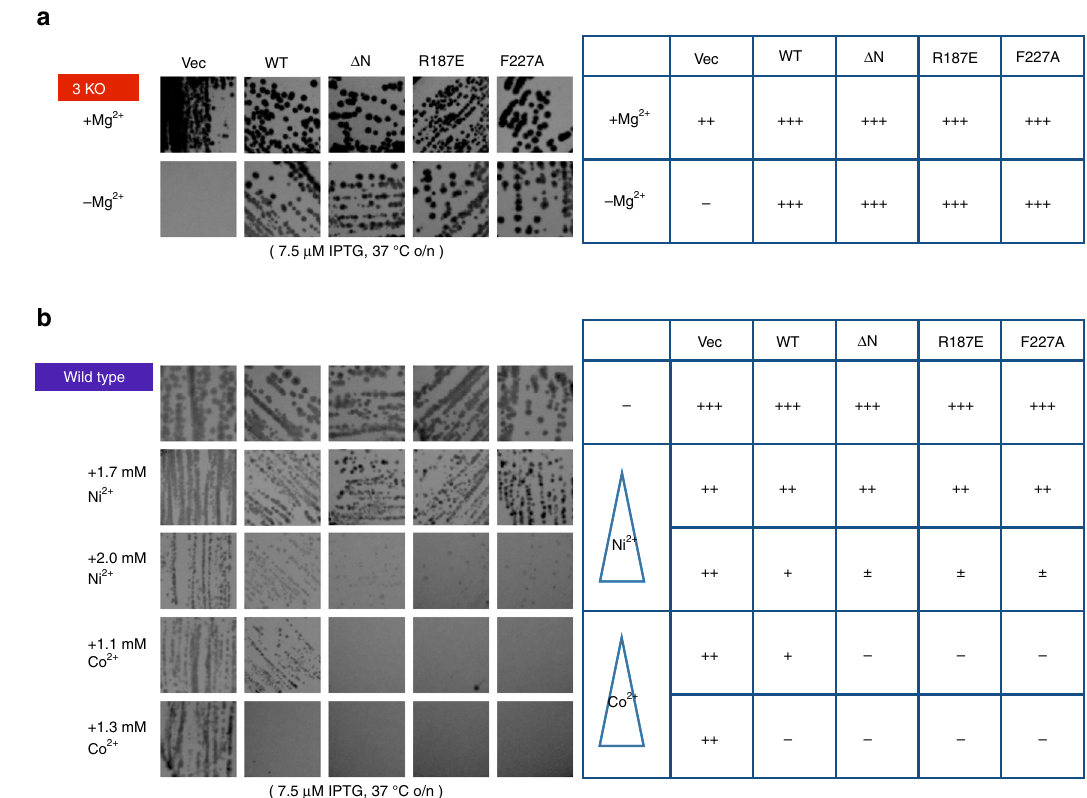
Fig. 6 E. coli growth assay of ATP-binding site mutants. a Mg 2+ -auxotrophic growth complementation assay. The Mg 2+ -auxotrophic E. coli strain, transformed with each plasmid, was streaked on LB or LB with 100 mM MgSO 4 . b Co 2+ and Ni 2+ sensitivity assays. The wild type E. coli strain (W3110 DE3), transformed with each plasmid, was streaked on LB or LB with 1.7 mM Ni 2+ , 2.0 mM Ni 2+ , and either 1.1 mM Co 2+ or 1.3 mM Co 2+ , and the colony growth was monitored. The growth of each transformant is indicated as “ +++ ” (similar to that of empty vector), “ ++ ” (less), “ + ” (scarcely any), “ ± ” (severe growth retardation) and “ − ” (no growth at